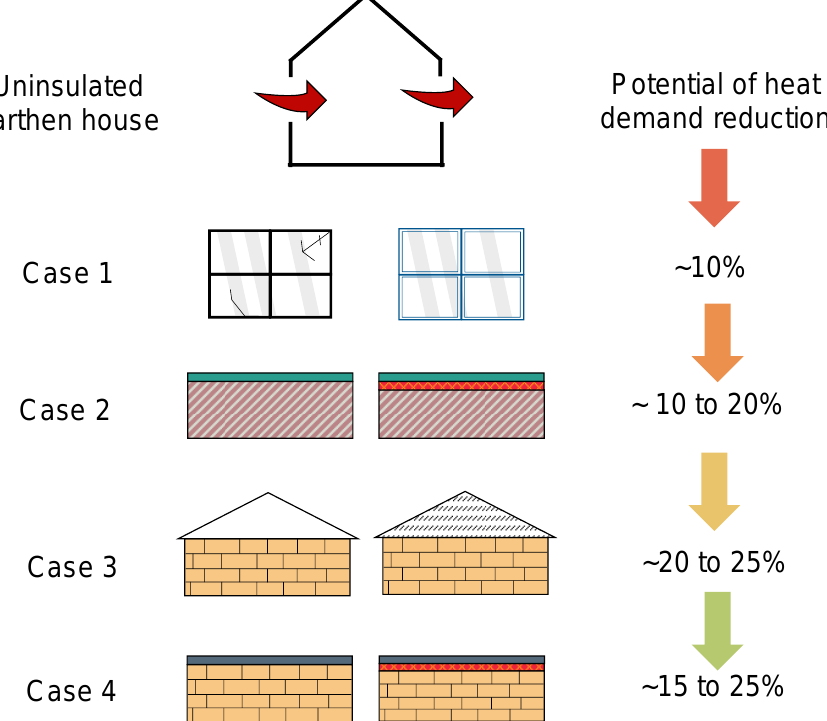
Figure 22. Recommended sequential energy efficiency parameters to reduce annual domestic space heating demand of vernacular Kyrgyz house.